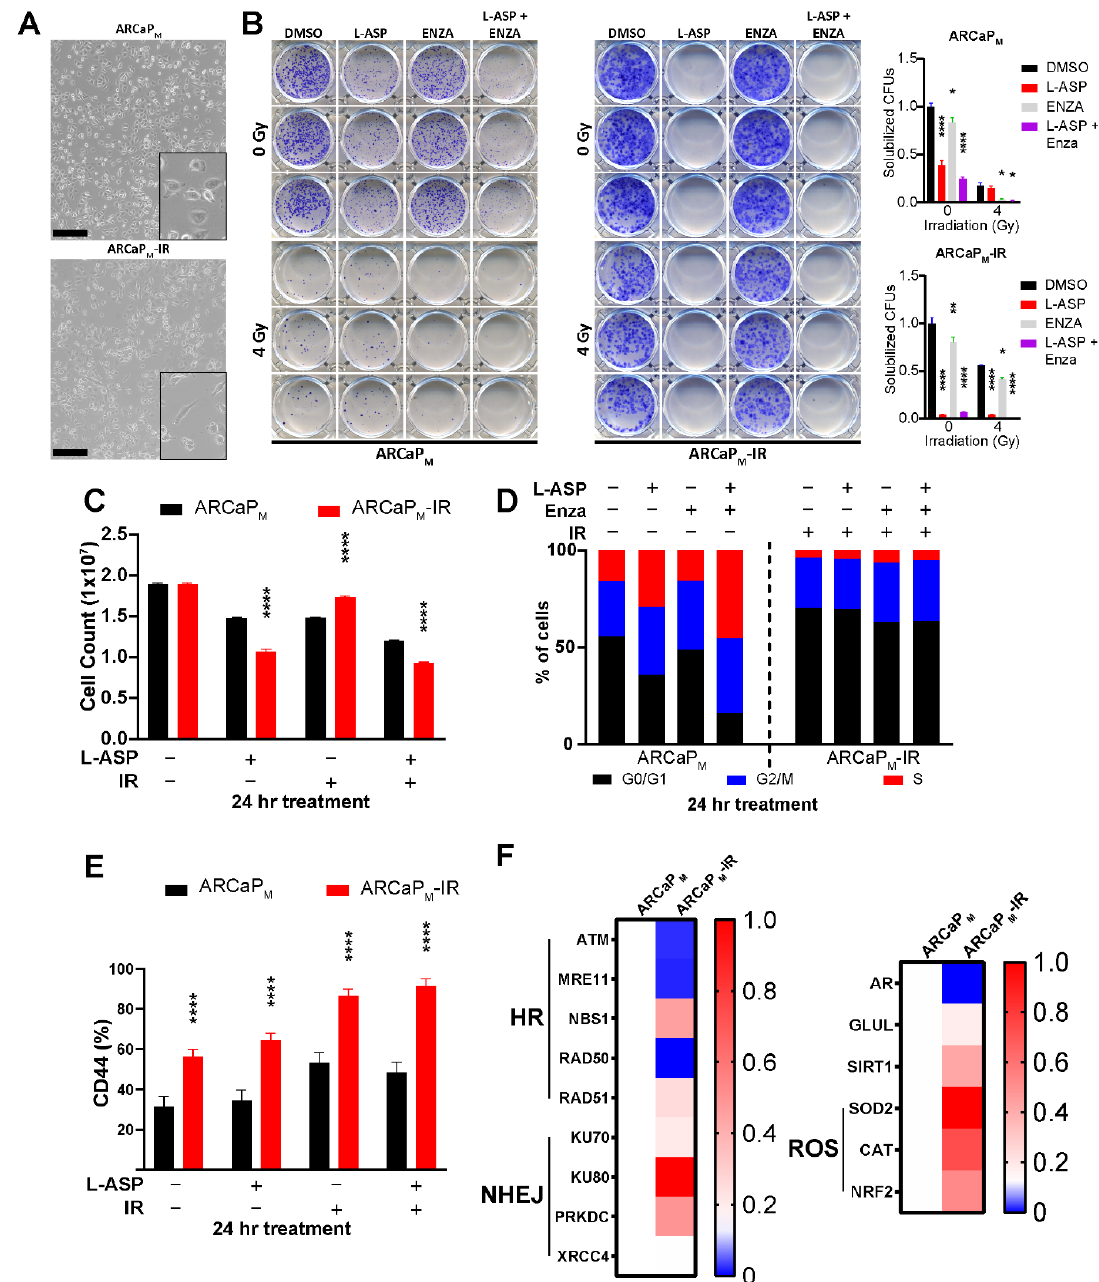
Figure 5. L-ASP sensitizes radio-resistant PCa to irradiation. ( A ) Representative images highlight morphological differences in parental ARCaP M and ARCaP M -IR cells; Scale bar, 250 µm. ( B ) Clono- genic assays performed with ARCaP M and ARCaP M -IR cells were quantified 10 days after treatment with L-ASP, enzalutamide, or both, with and without irradiation (2 Gy). Solubilized CFUs were normalized to the untreated control. ( C ) Parental ARCaP M and ARCaP M -IR cell were counted 72 h after administering L-ASP, enzalutamide, and/or irradiation (4 Gy). ( D ) Cell cycle analysis of AR- CaP M and ARCaP M -IR 24 h after L-ASP, enzalutamide, and/or irradiation (4 Gy) was analyzed by FACS using propidium iodide staining. ( E ) ARCaP M and ARCaP M -IR cell surface CD44 expression was measured by FACS 24 h after L-ASP, enzalutamide, and/or irradiation (4 Gy). ( F ) mRNA ex- pression of DNA damage repair proteins and reactive oxygen species (ROS) regulators were meas- ured. All studies are reported as a mean of at least three independent experiments (* p < 0.05, ** p < 0.01, **** p < 0.0001).